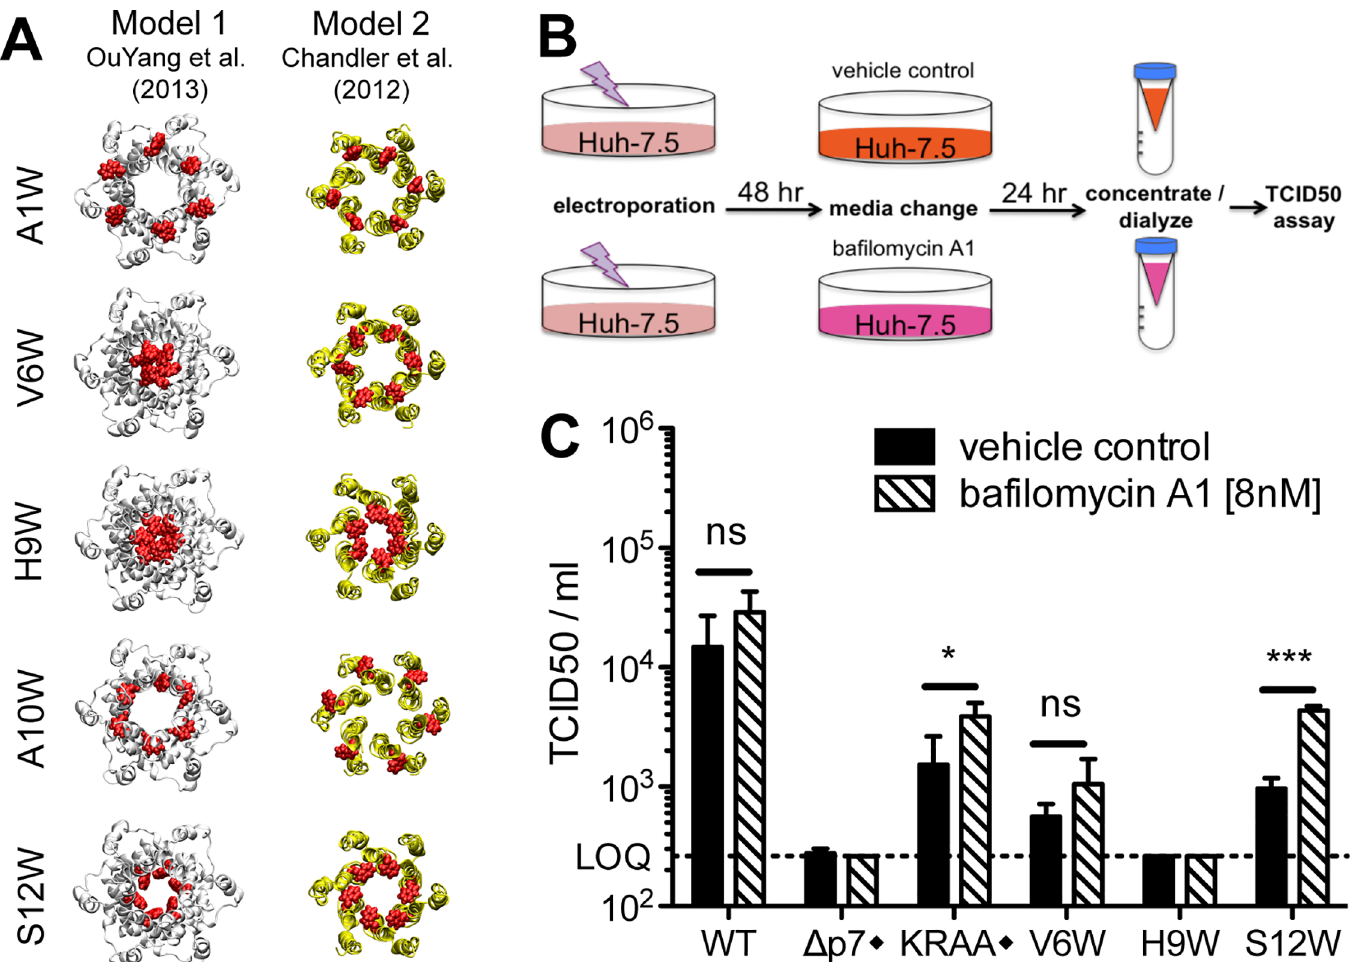
Fig 6. Identification of putative ion channel defective mutants by homology modeling and bafilomycin A1 rescue. A) Molecular models of N-terminal region mutants that yielded > 1 log reduction in infectious virus production compared to wild-type in a bicistronic context. The mutated residue Trp side chains are shown in red. Models provide insight into whether the mutation is likely to block the pore (e.g. H9W and S12W), disturb p7 intramolecular interactions (e.g. A10W), or interrupt p7 interactions with binding partners (e.g. A1W, A10W). B) Bafilomycin A1 rescue experiment schematic. Forty-eight hours post- electroporation, Huh-7.5 cells replicating control or p7 mutant viruses were supplied with cell culture medium containing bafilomycin A1 [8nM] or DMSO. Supernatants were collected 24 hours post-treatment, concentrated and dialyzed to remove excess bafilomycin A1, and then tittered on na ï ve Huh-7.5 cells to quantify infectious virus production. C) Resulting infectious virus titers from the experiment outlined in panel b. Mutant viruses yielding significantly more infectious virus production under bafilomycin A1 conditions compared with DMSO were identified using unpaired t-tests. Statistical results are indicated as follows: ns = not significant, * p < 0.05, and *** p < 0.0001. LOQ: lower limit of the limiting dilution assay. Black diamond ( ◆ ) indicates that these control viruses are monocistronic; all others shown are bicistronic. KRAA denotes J6/JFH with K33A and R35A mutations in